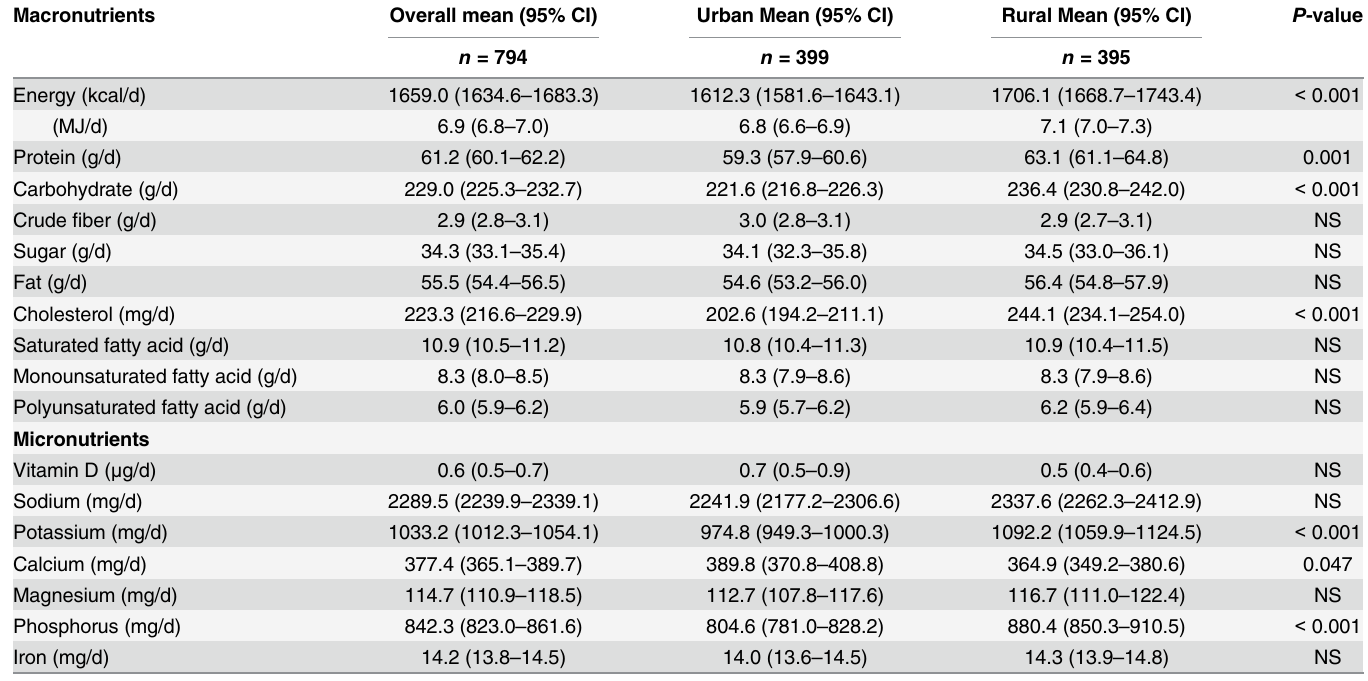
Table 5. 7-d nutrient intake for adolescents age 13-y-old attending secondary schools by places of